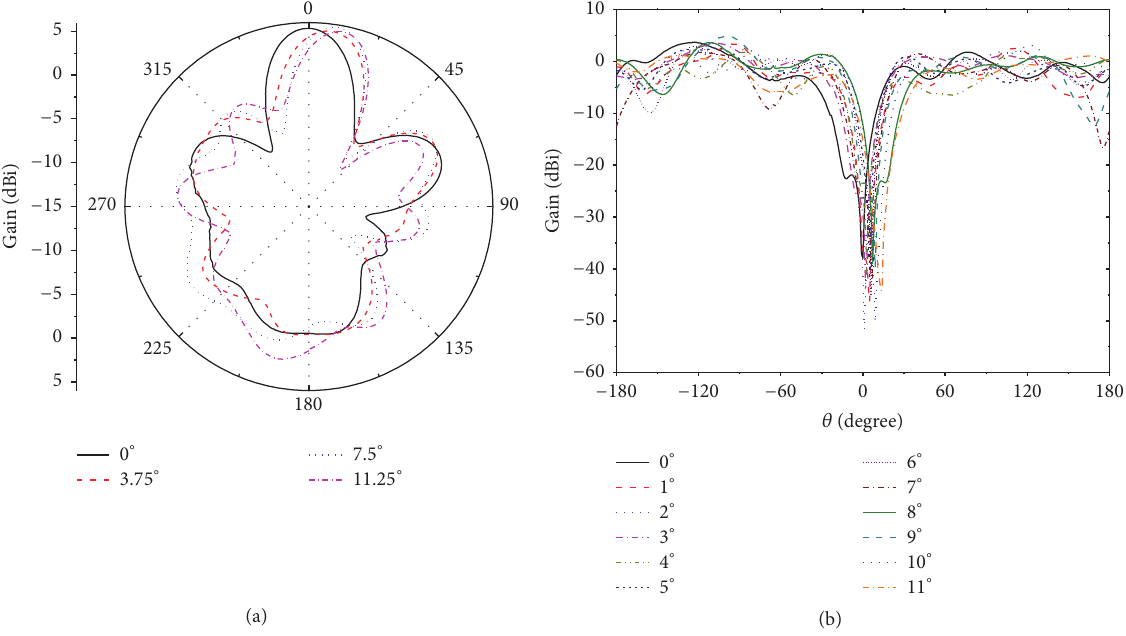
Figure 18: Radiation patterns for examining the continuous tunability. (a) High-gain modes. (b) Nulling